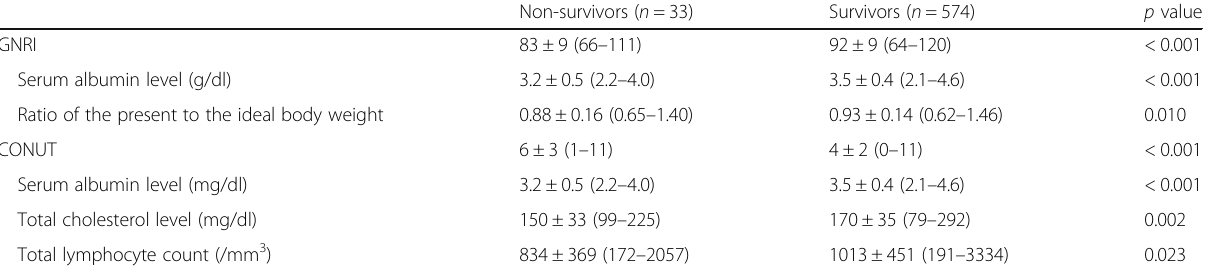
Table 2 Comparison of the GNRI and CONUT between non-survivors and survivors